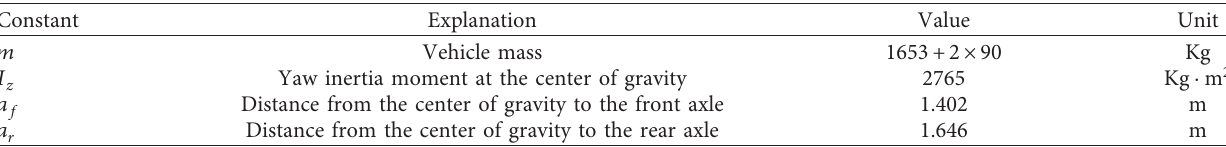
Figure 1: Vehicle lateral dynamics model. Table 1: Simulation vehicle parameters.